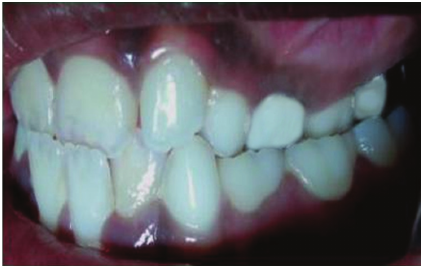
Figure 2: Lateral intraoral view showing anterior and posterior crossbite on the left